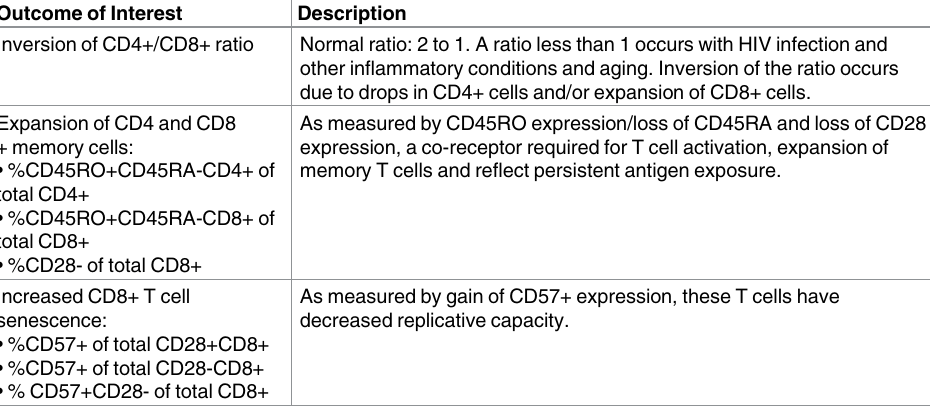
Table 1. Outcomes of interest: T cell abnormalities consistent with immune risk phenotype.